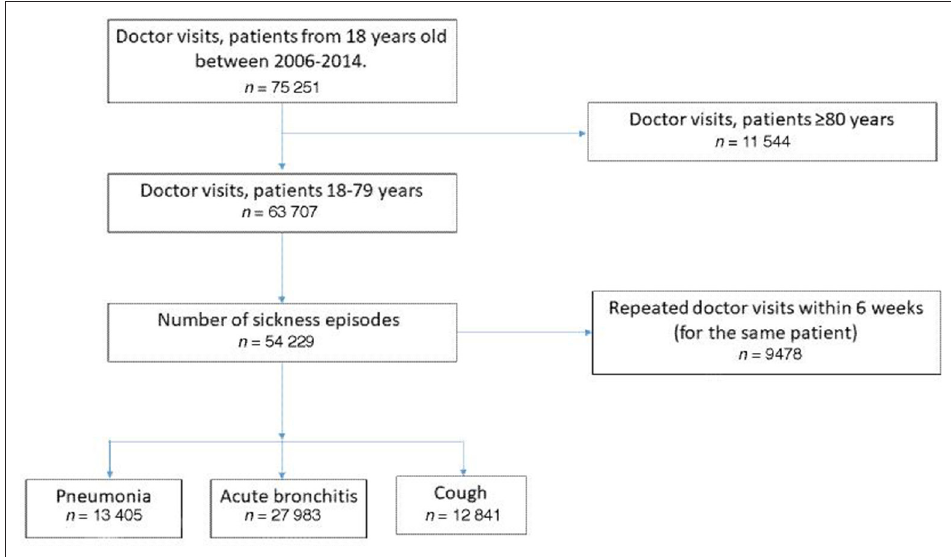
Figure 1 Flowchart of the inclusion and exclusion